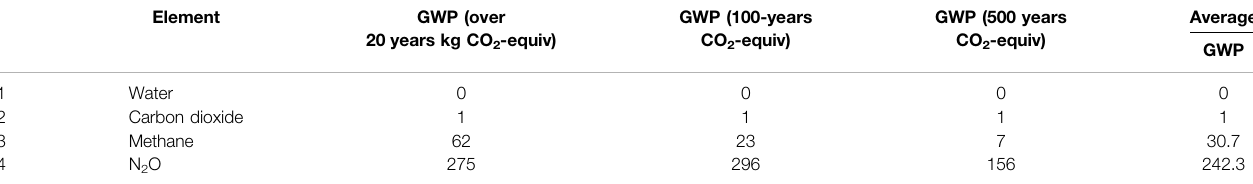
TABLE 1 | Global warming potential for various substances/gases (MacLeod et al., 2011; Demirel and Demirel, 2014).